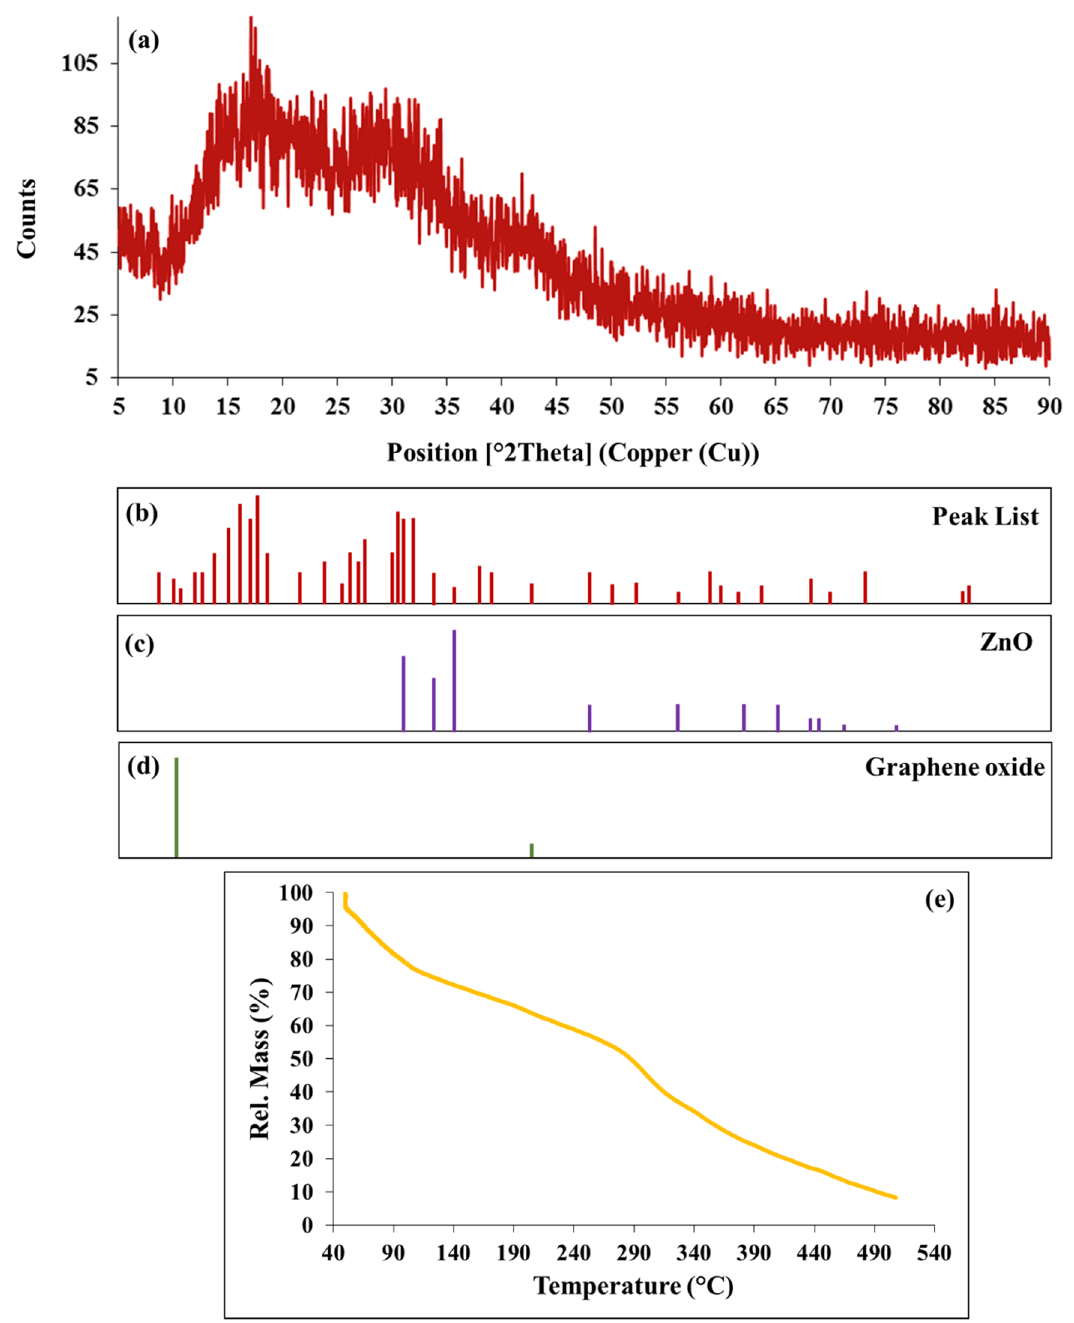
Figure 5. ( a ) XRD pattern and ( b ) peak list of Graphene oxide-lignin/silk fibroin/ZnO nanobiocomposite ( c ) reference of ZnO and ( d ) graphene oxide. ( e ) TGA curve of Graphene oxide-lignin/silk fibroin/ZnO